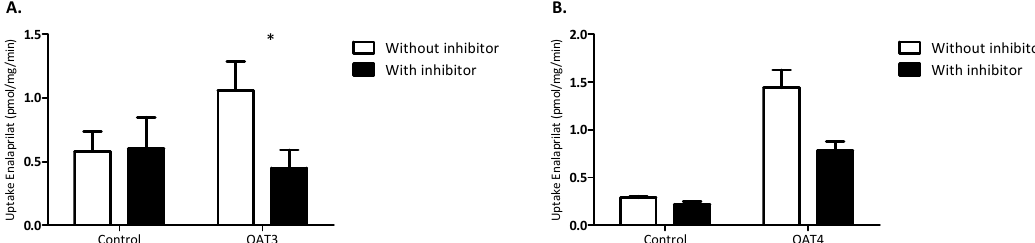
Figure 4. Transport of enalapril by OAT3 and OAT4 was effectively inhibited by the OAT inhibitor MK571. Effect of the OAT inhibitor MK571 (10 µM) on the uptake of enalaprilat into HEK293 cells overexpressing OAT3 ( A ) and OAT4 ( B ). Transport is expressed as pmol/mg/min and presented as mean ± SEM. Data were pooled from three independent experiments. An asterisk indicates a statistically significant difference from the non-inhibited transporter by a paired sample T -test (* p < 0.05).